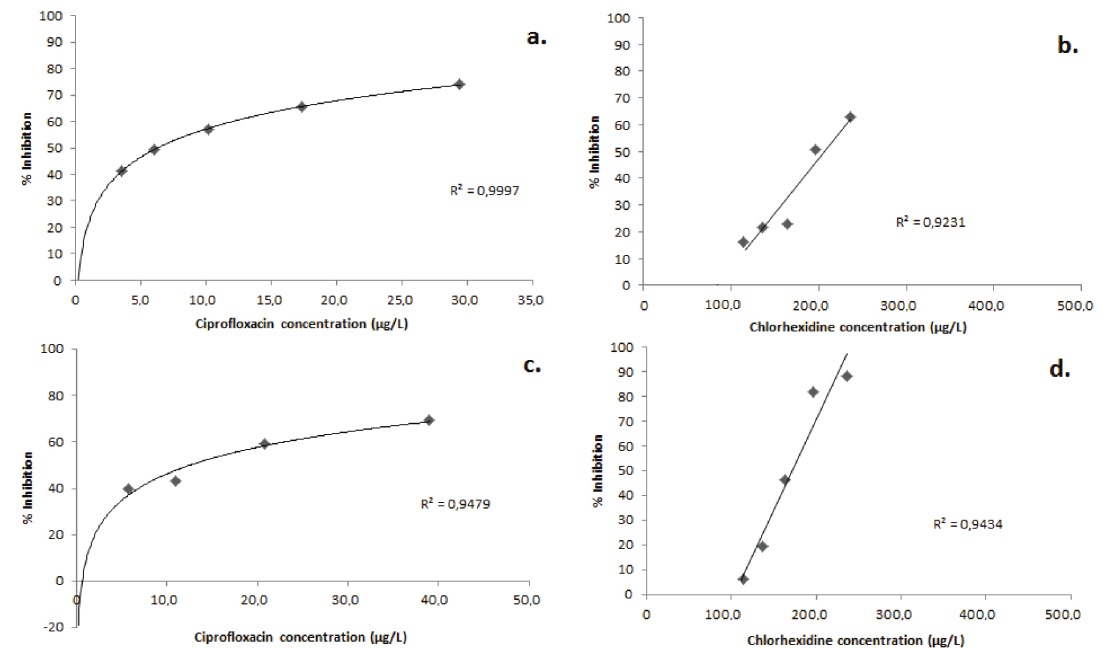
FIGURE 2 - Inhibition of growth of cultures of M. aeruginosa after 96 hours of exposure to ciprofloxacin (a) or chlorhexidine (b). Inhibition of growth of cultures of M. panniformis after 96 hours of exposure to ciprofloxacin (c) or chlorhexidine (d).